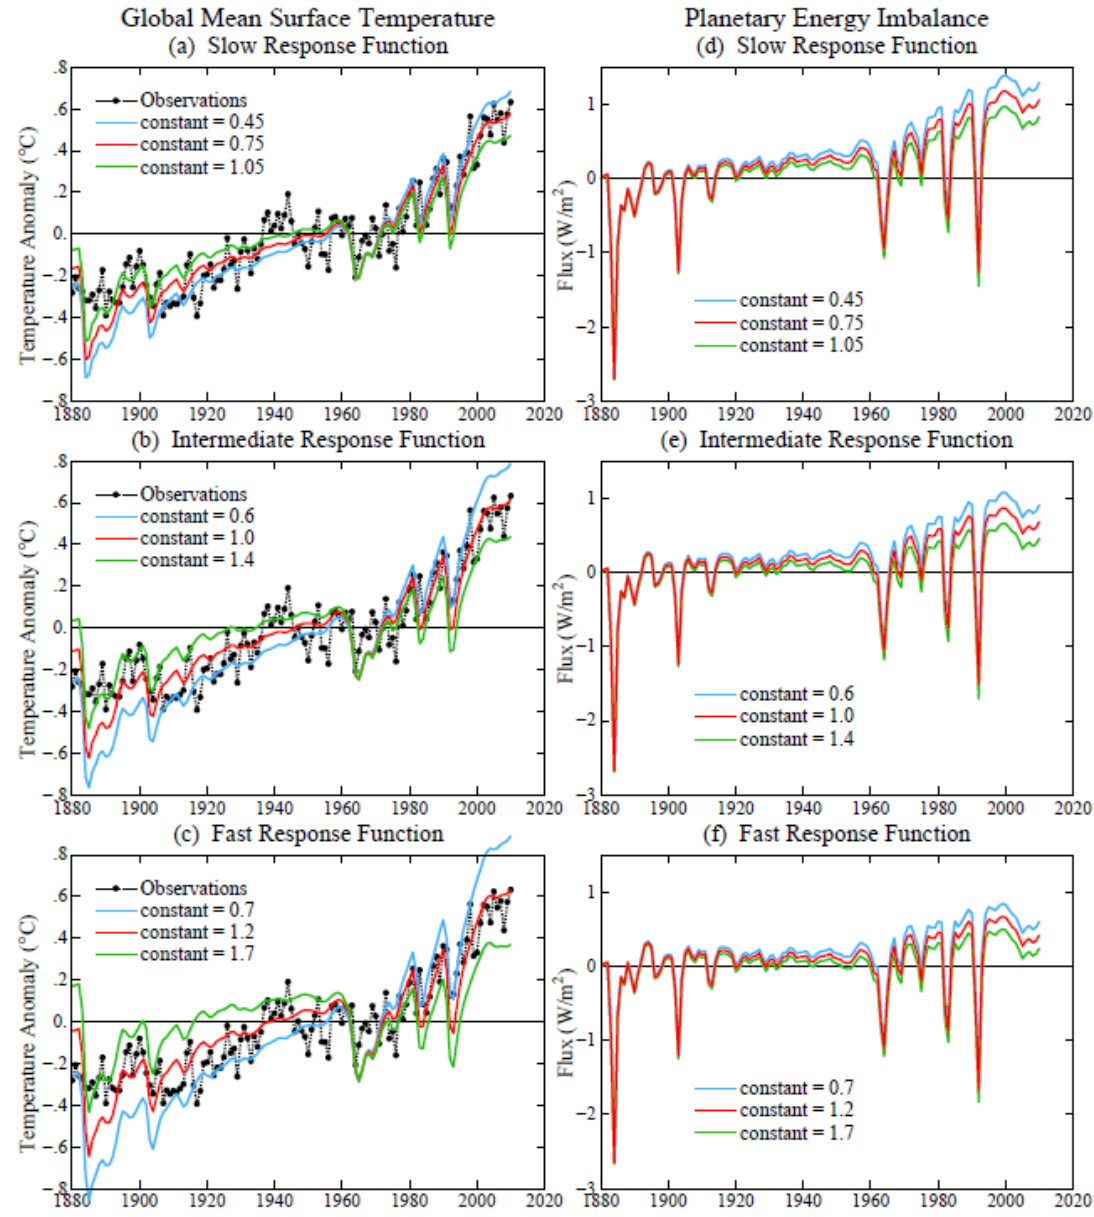
Fig. 7. Green’s function calculation of surface temperature change and planetary energy imbalance. Three choices for climate response function are slow (top row, same as GISS modelE-R), intermediate (middle) and fast response (bottom). Factor “constant” multiplies aerosol forcing of Fig. 1.